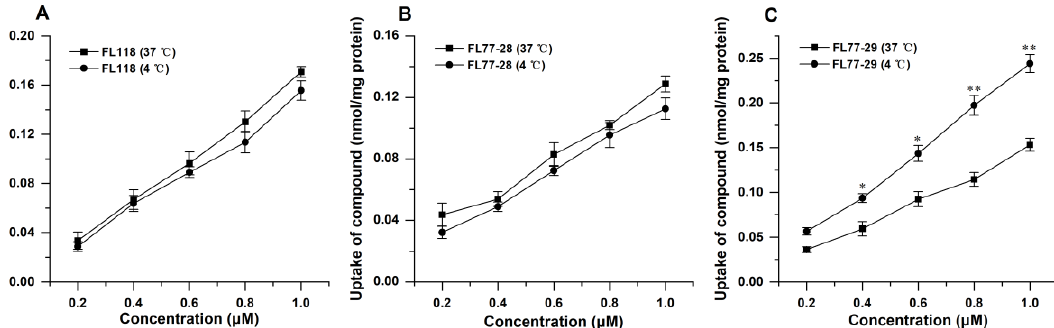
Figure 4. Effect of temperature on the uptake of FL118 ( A ), FL77-28 ( B ), and FL77-29 ( C ) at 4 ° C or 37 ° C for 4 h in Caco-2 cells. Results are the mean ± SD ( n = 3). * indicated p < 0.05 and ** indicated p < 0.01, compared with the results at 4 °C.